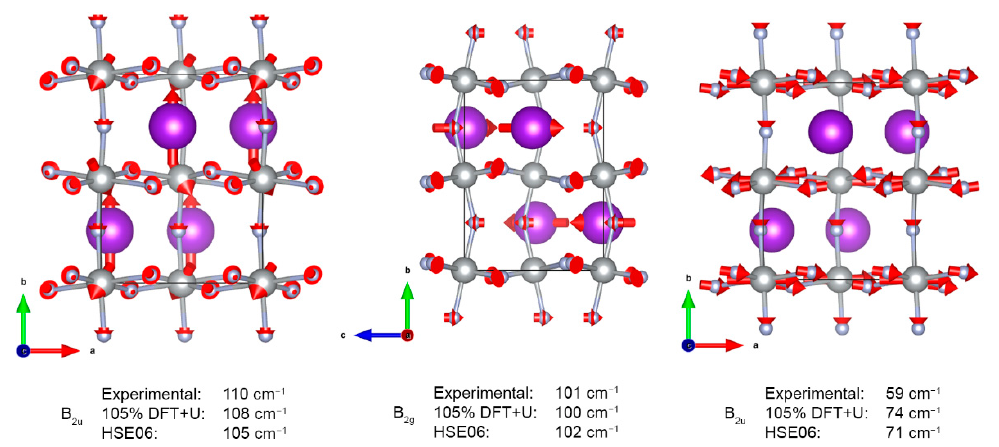
Figure 6. Normal vectors for selected fundamentals. Red arrows show the direction and relative amplitude of atomic movement.